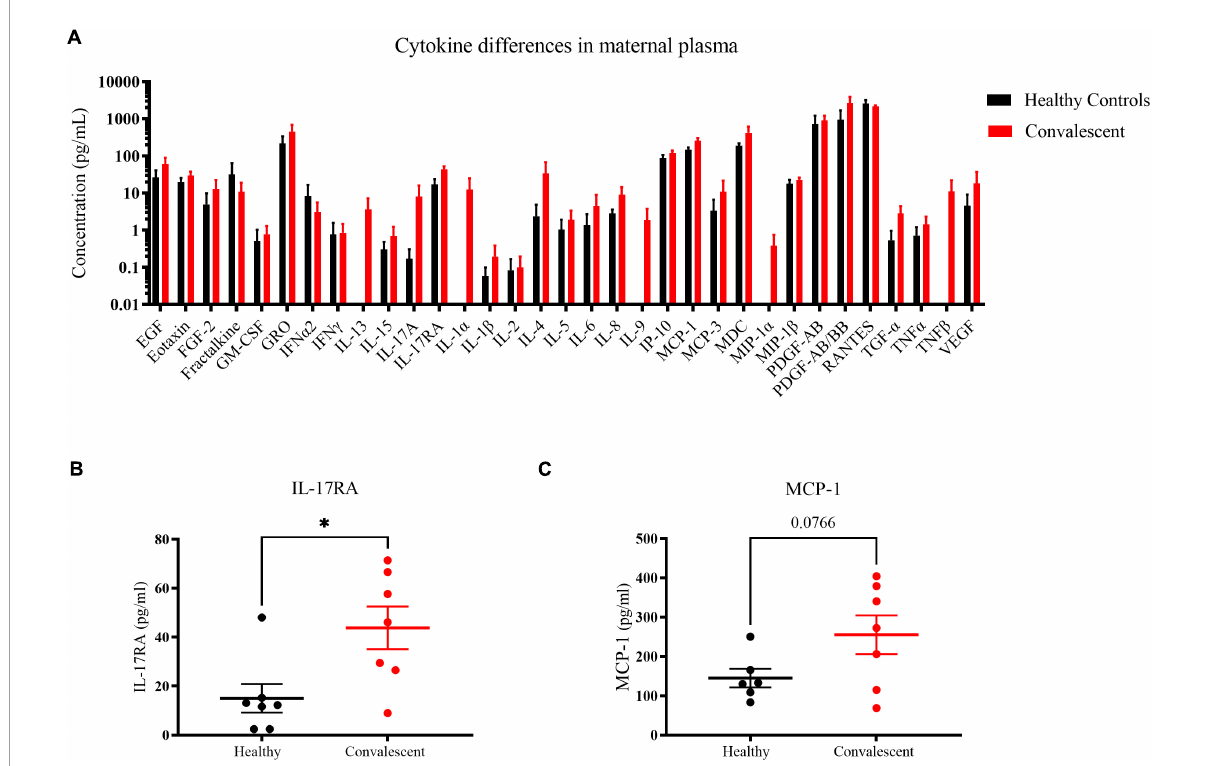
FIGURE6 Cytokine profile differences in healthy and convalescent mothers’ plasma. Using 1-month post-partum plasma ( n = 6 for controls and n = 7 for cases), cytokines were evaluated using the 41-plex Luminex TM assay. (A) A representation of all cytokines that were detected, (B) IL-17RA levels and (C) MCP-1. Convalescent mothers are represented in red while healthy controls are represented in black. Bar graphs represent the average log(concentration) from the samples from the respective groups in A while the measured concentrations were used for (B,C) . * p <